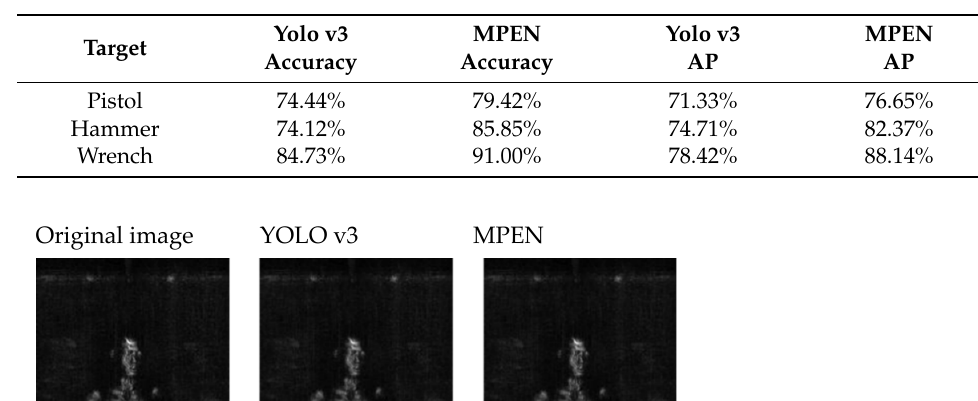
Table 2. Performance comparison of recognition targets.